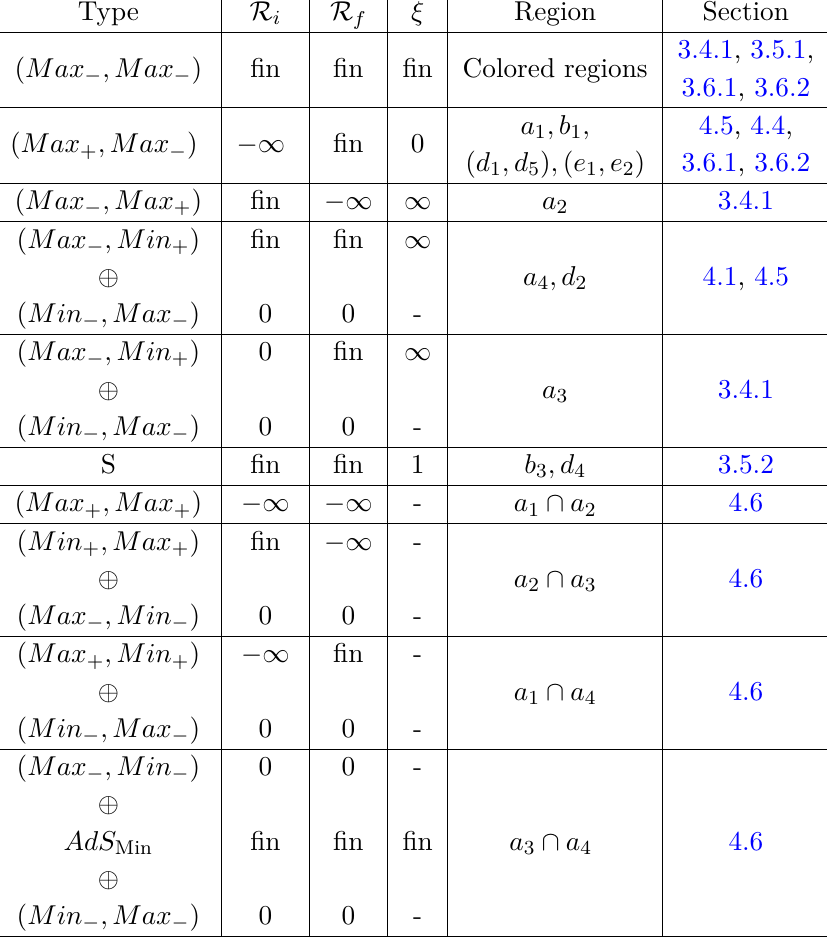
Table 1 . In this table we address the properties of different types of solutions in the space of the solutions. For example a means the intersection point of a and a boundaries. The boundaries 1 ∩ a 2 1 2 in the fifth column are defined in figure 50a, or 8. The information of the second and third columns are also portrayed in figures 51a,